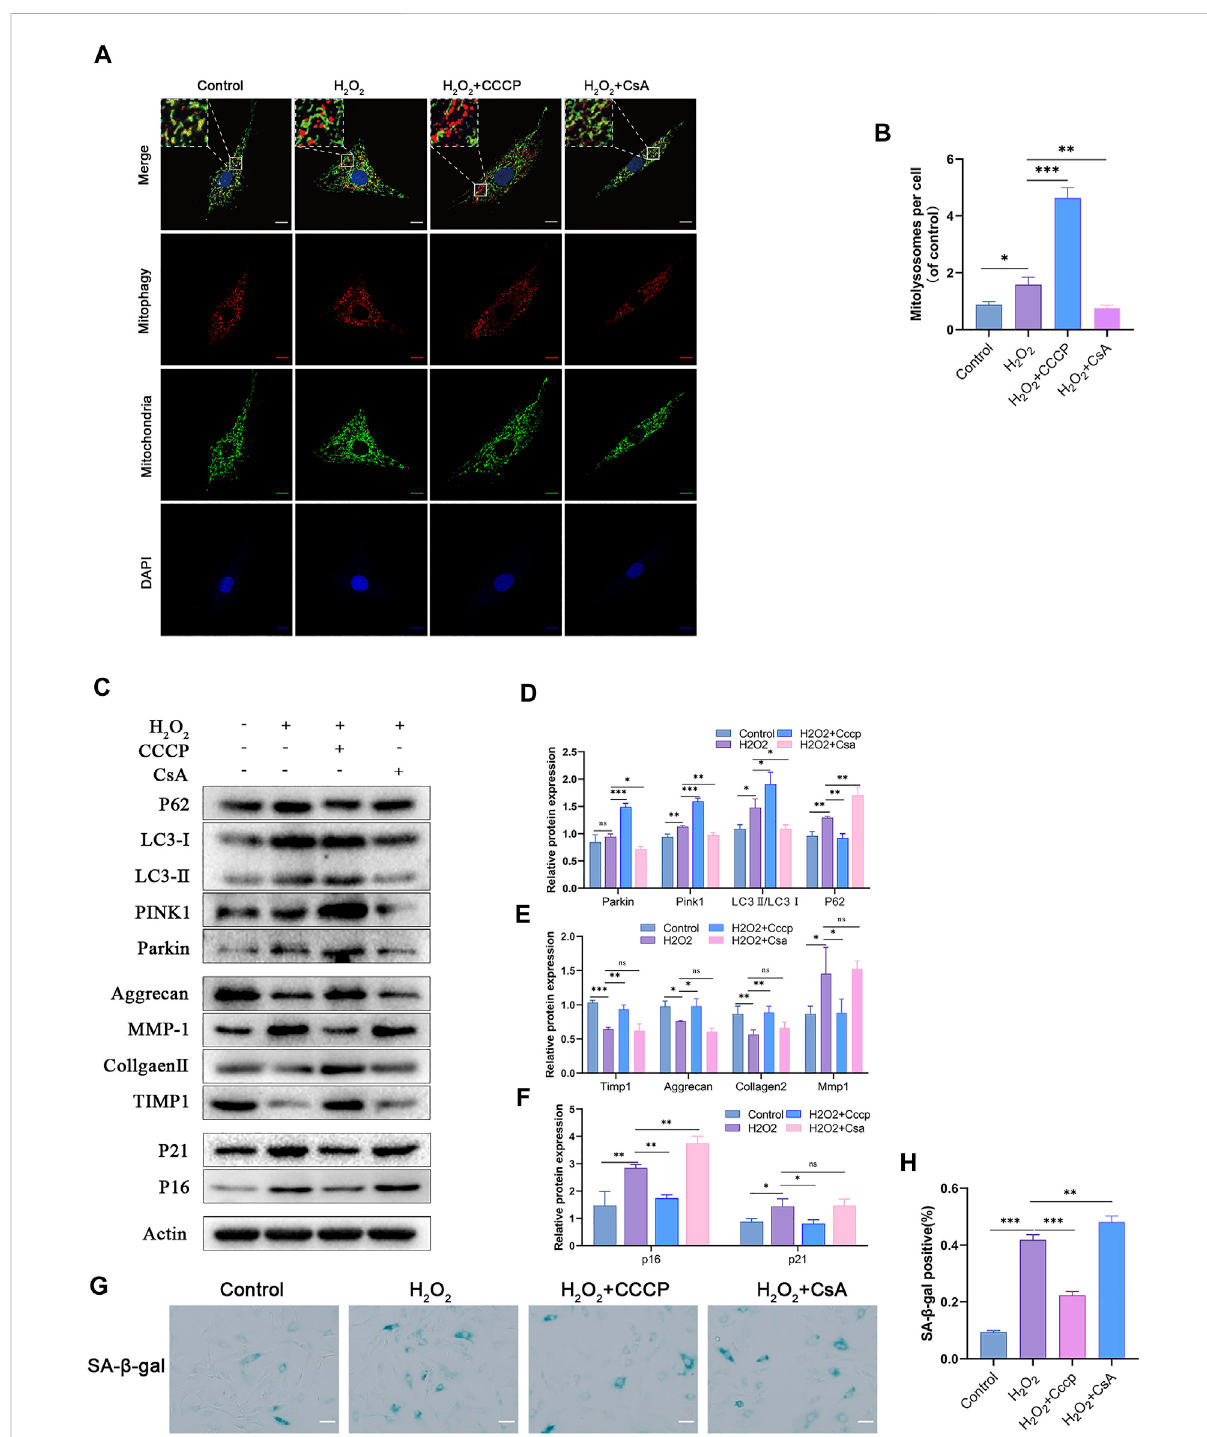
FIGURE 3 Mitophagy inhibits H 2 O 2 -induced senescence and ECM degradation in rat NPCs. (A – B) MITO-QC was used to detect mitolysosomes in rat NPCs and quanti fi cation (scale bar: 10 μ m). NPCs were treated with or without H 2 O 2 conditions in the presence of CCCP, CsA. (C – F) Western blot and quanti fi cation of P62, LC3, PINK1, Parkin, Aggrecan, MMP-1, Collagen Ⅱ , TIMP1, P21, P16 in rat NPCs. (G – H) Sa- β -gal staining and quanti fi cation (scale bar: 50 μ m). All experiments were performed as means ± SD of 3 times in duplicates. ( n = 10). * p < 0.05, ** p < 0.01, *** p < 0.001, ns p >